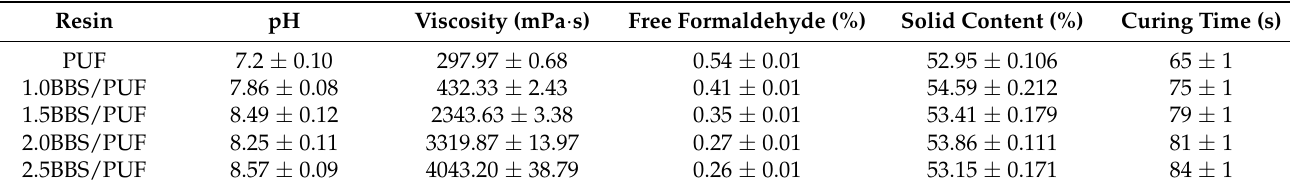
Table 2. Physical properties of PUF and BBS-modified PUF